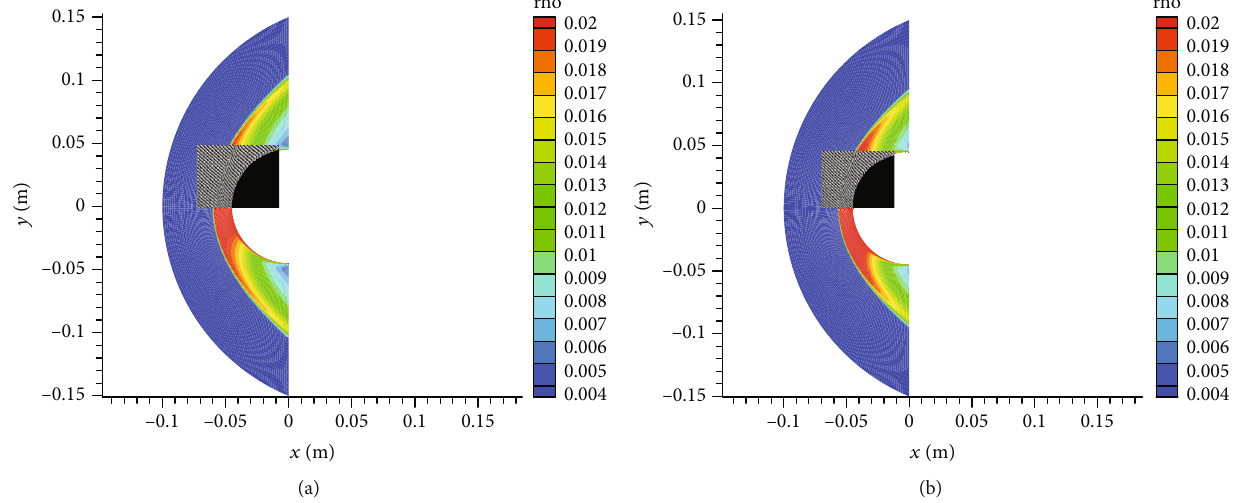
Figure 7: Comparison between the numerical and experimental results. Table 1: Properties of carbon/carbon